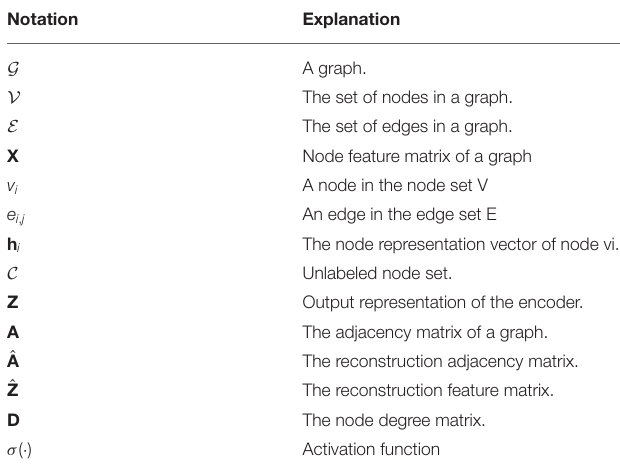
TABLE 2 | Commonly used notations with